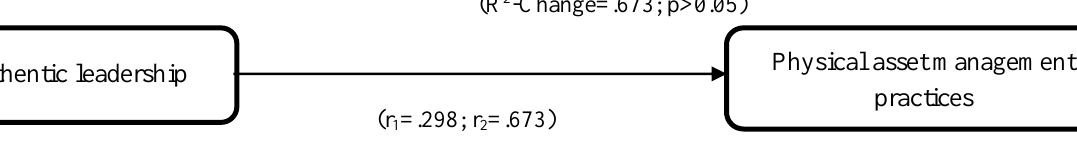
Figure 2: Investigation of the moderator effect of institutional framing variable on the relationship between authentic leadership and physical asset management practices.